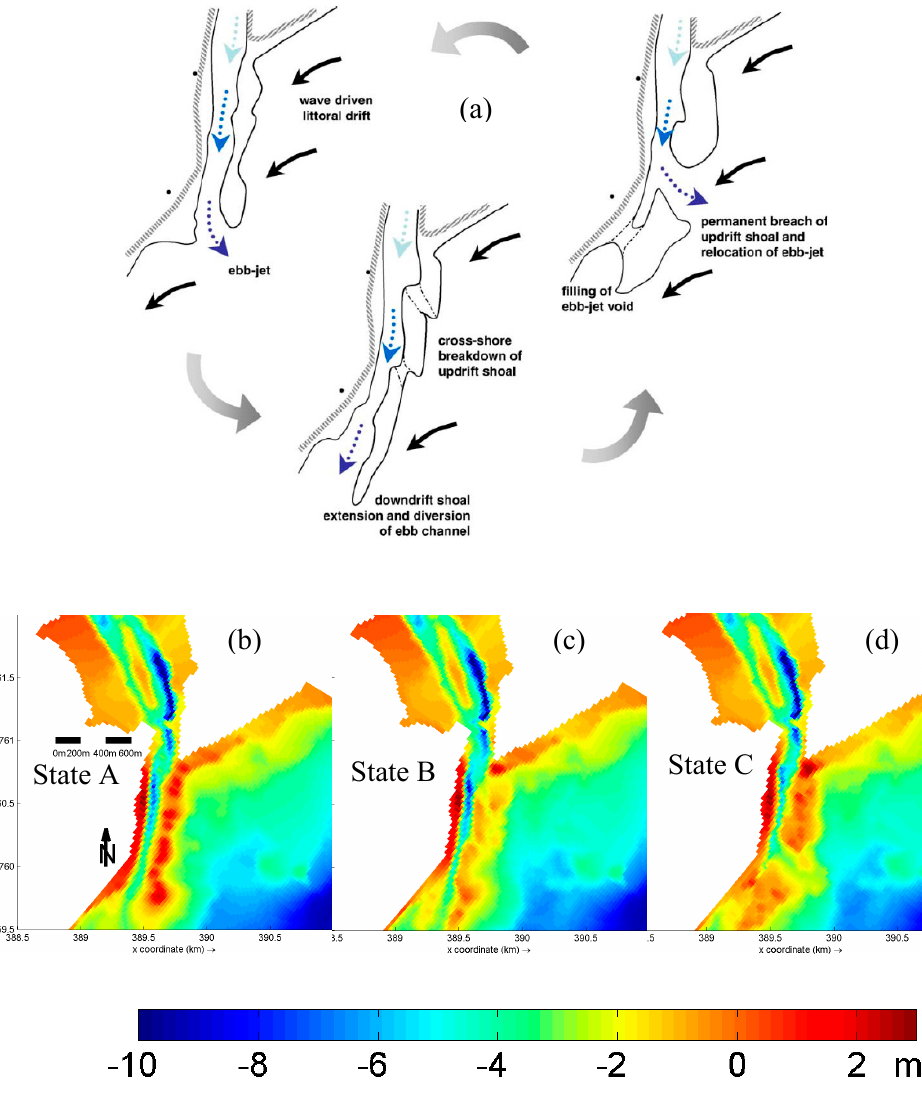
Figure 11. The historically cycled morphodynamic states of Deben Estuary ( a ): adapted from Burningham et al. [32]); the three representative bathymetry states are used as initial bathymetry states for the numerical model in this study (bottom): State A ( b ); State B ( c ); State C ( d ). (The color bar shows depths referred to current mean sea level) (adapted from Yin et al. [27]). All figures are adapted with permission from ELSEVIER, 2006 and 2019. Table 3. Modelling scenarios used in this study during the spring tide surge conditions.